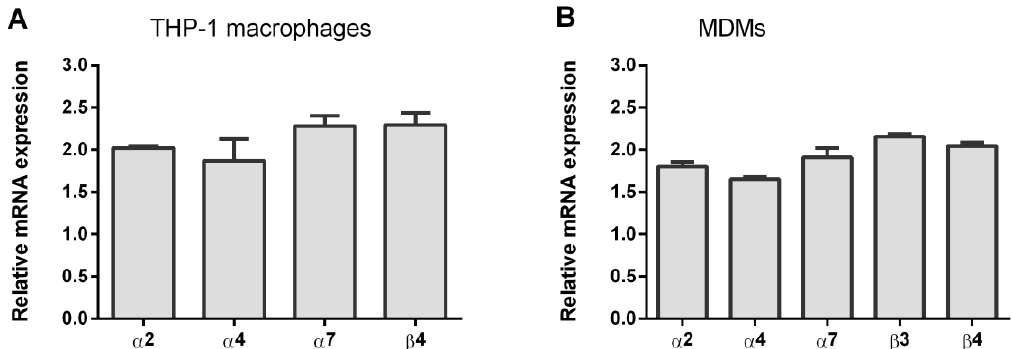
Figure 1. Relative expression of nicotinic acetylcholine receptor (nAChR) subunits transcripts ( A ) human monocytic cell line macrophages (THP-1M φ ) and ( B ) monocyte-derived macrophages (MDMs) examined by qRT-PCR. Data are shown as relative expression ± SEM, normalized to the endogenous β -actin expression. 3.2. Expression of α 7 nAChR on the surface of THP-1M φ and